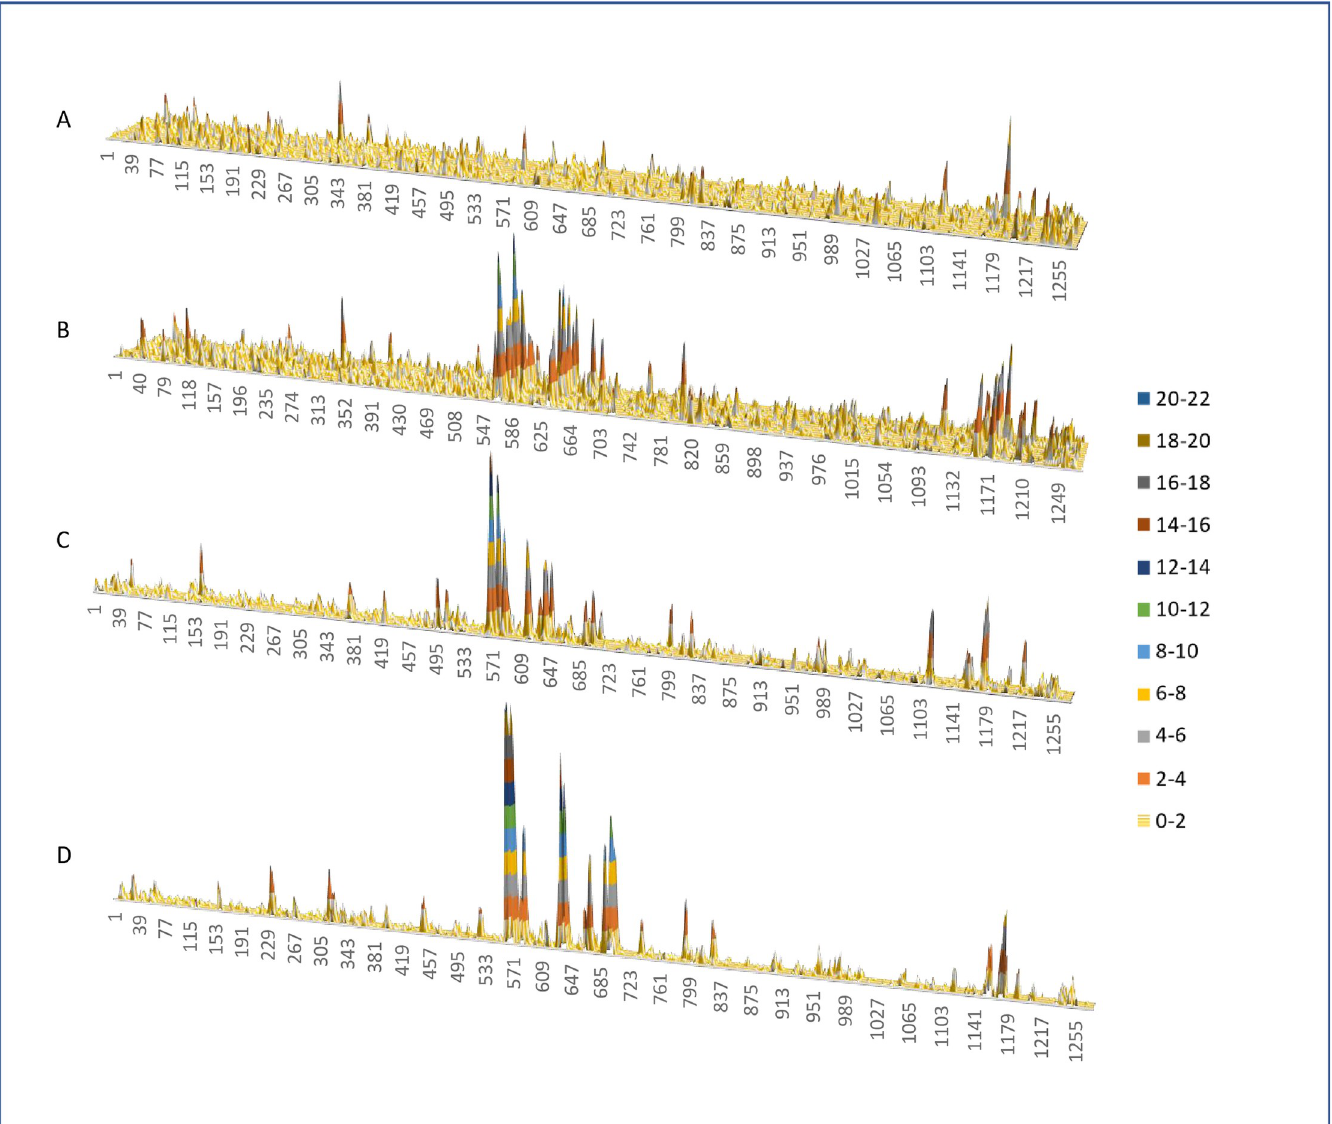
Fig 2. Linear epitope mapping of spike protein in mRNA vaccine recipients. The relative specificty for linear epitopes or PIWAS score (Y-axes, color coded key to right) are graphed across the spike primary sequence (amino acid numbers on X-axis) for paired samples from subjects# 1–20 in panel A (pre-vaccine) and panel B (post-vaccine) that received Pfizer-BioNTech vaccine. Panel C shows data from subjects # 21–28, post Moderna vaccine and panel D shows vaccinated subjects# 29–33 that previously had COVID-19.